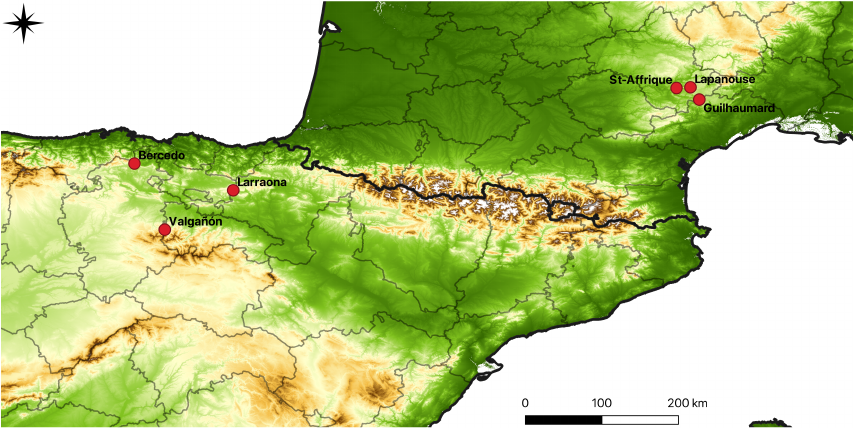
Figure 1. Map of Ophrys aveyronensis populations. O. aveyronensis populations were sampled across the geographic range of the species in Southern France and Northern